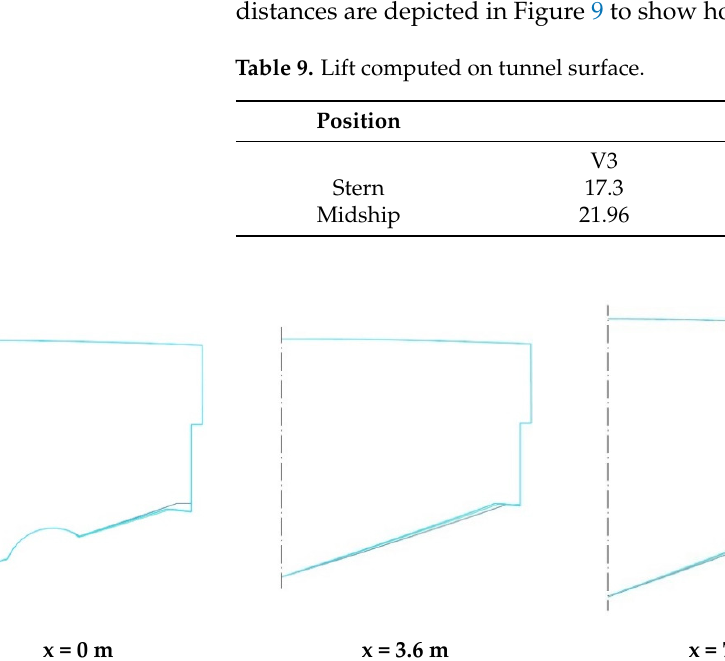
Figure 9. Transversal sections at different longitudinal distances for versions V3, V4 and V6.